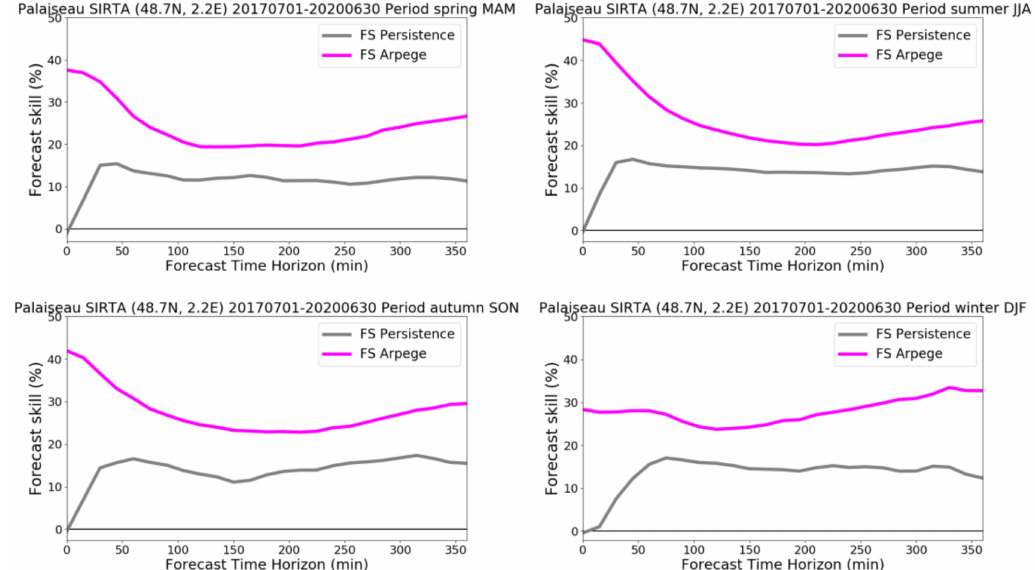
Figure 6. Forecast skills for the four seasons defines by the following trimesters (top-left: March, April and May; top-right: June, July and August: bottom-left: September, October and November; bottom-right: December, January and February.